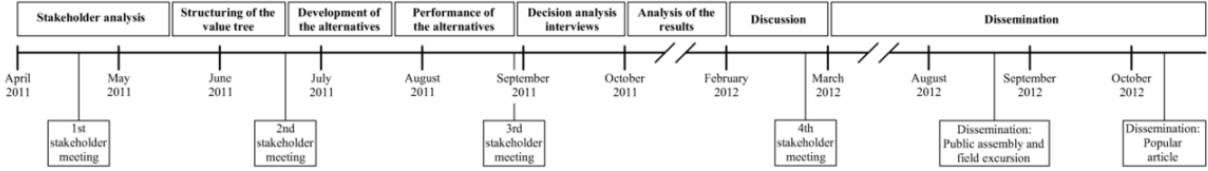
Fig. 2. Decision analysis process in the Rokua case. Figure 2. Decision analysis process in the Rokua case.